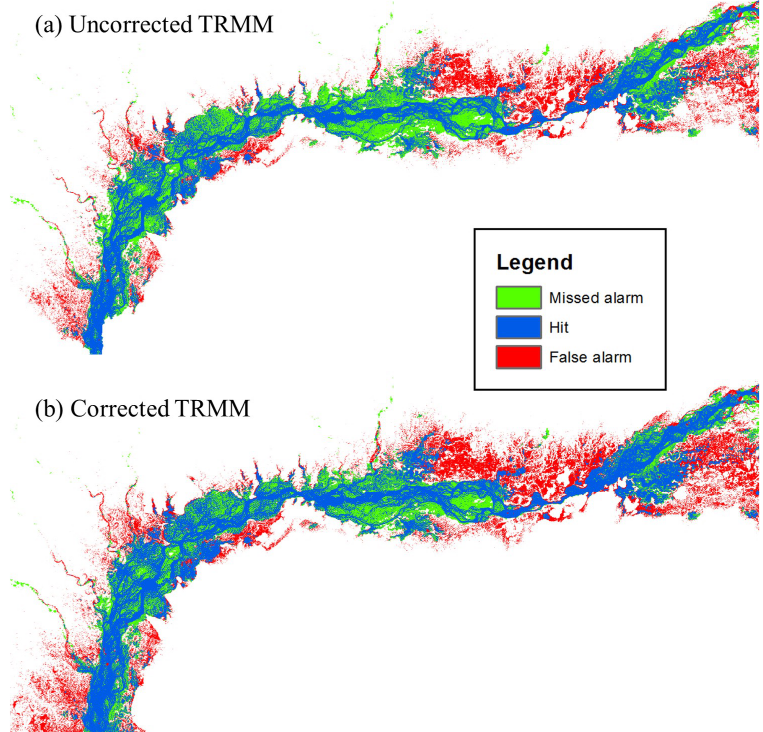
Figure 8. Comparison between hit, missed alarm and false alarm for the flood of 23 September